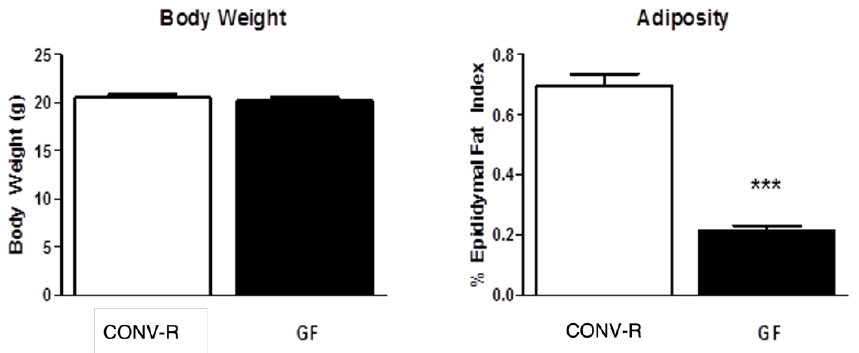
Figure 1. Body weight and adiposity of GF and CONV-R mice after a 5-h fast. Data are expressed as means ± SEM. *** denotes statistical difference between GF and CONV-R, *** p < 0.001.